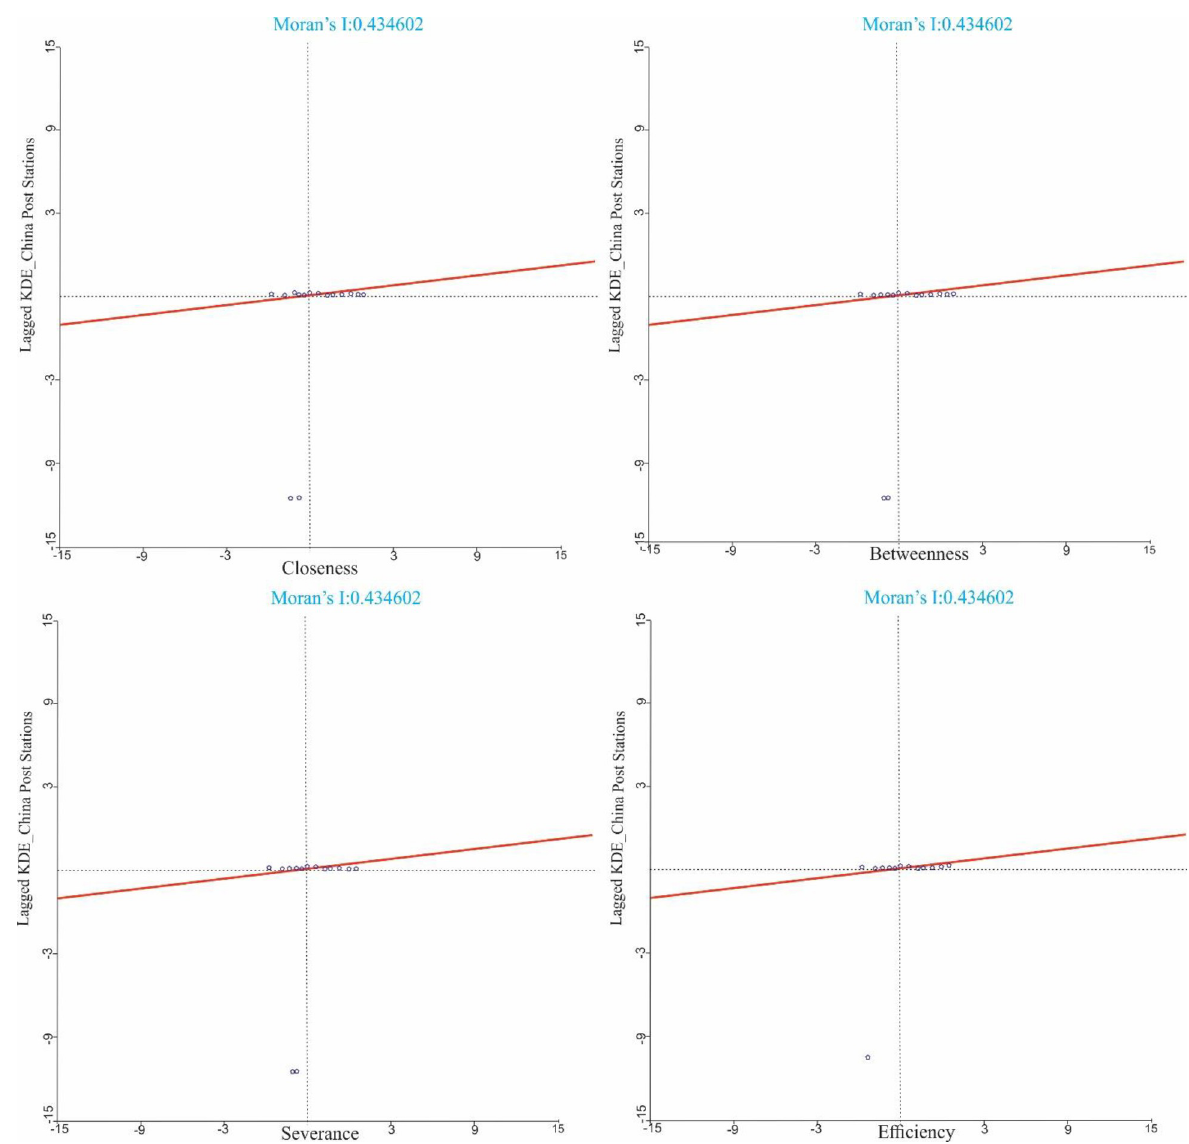
Fig 8. Moran scatter plot of the USN’s centralities and China Post